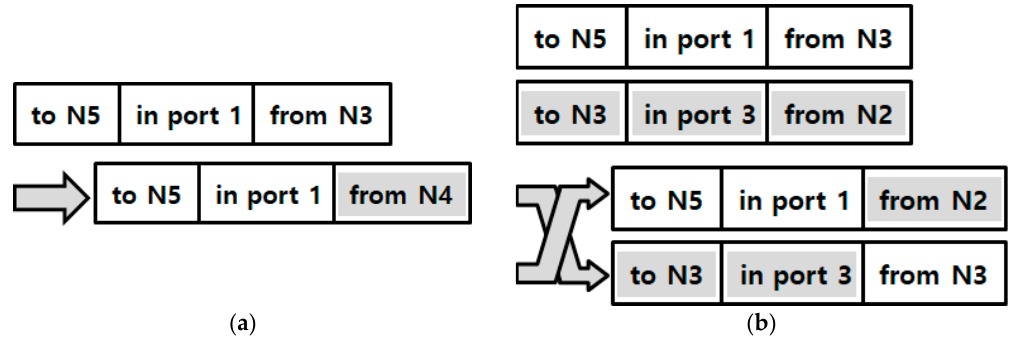
Figure 4. Mutation and crossover: ( a ) Example of mutation and ( b ) example of crossover.